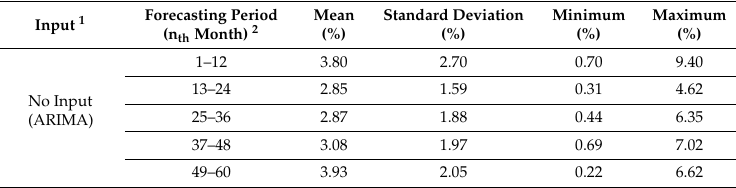
Table 5. Lists of meteorological factors in ARIMAX model and their MAPE (%) forecasting error measure with respect to the forecasting periods with descriptive